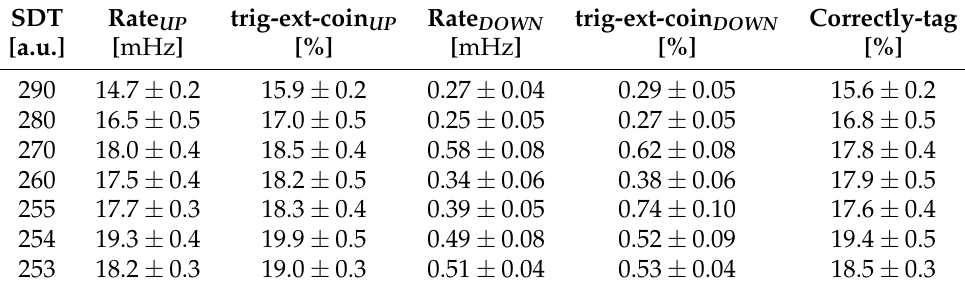
Table 5. As in Table 2, for a charge threshold equal to 75